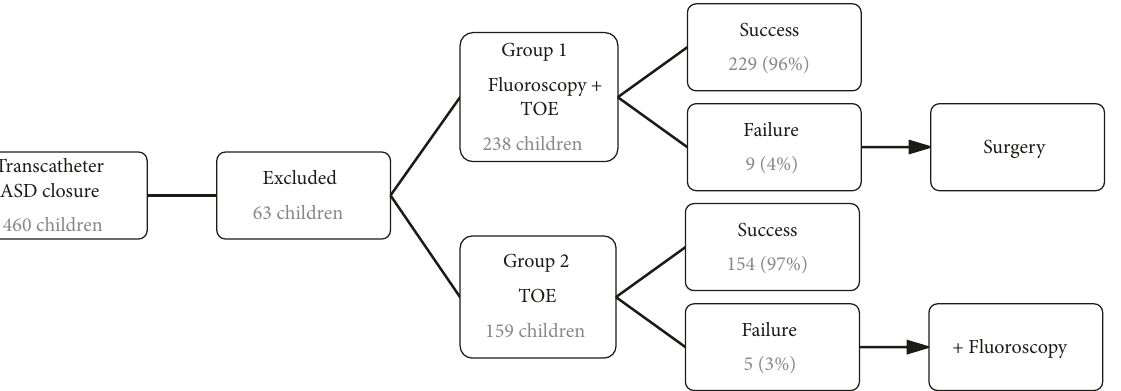
Figure 3: Patients flow chart showing all n=460 consecutive patients undergoing interventional ASD device closure between 2002 and 2016 and their distribution to the fluoroscopy group (group 1) and TOE alone group (group 2), as well as success and failure rates.